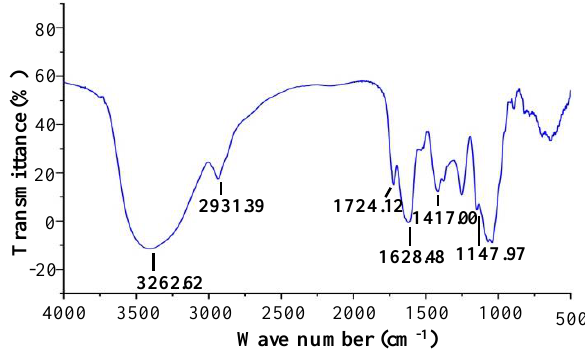
Figure 2. FT–IR spectra of Figure 2. FT – IR spectra of OPP-D. Figure 2. FT – IR spectra of OPP-D.